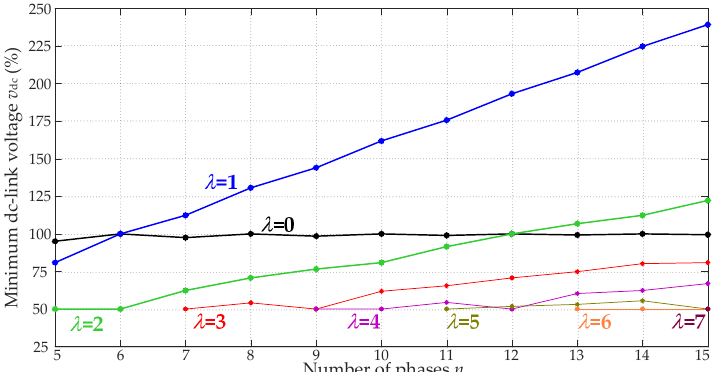
Figure 6. Required VSC line-current rating, normalized by machine phase-current rating, depending on n and the stator phase connection λ , for healthy drive (dashed) or single-line OC (solid) [22].